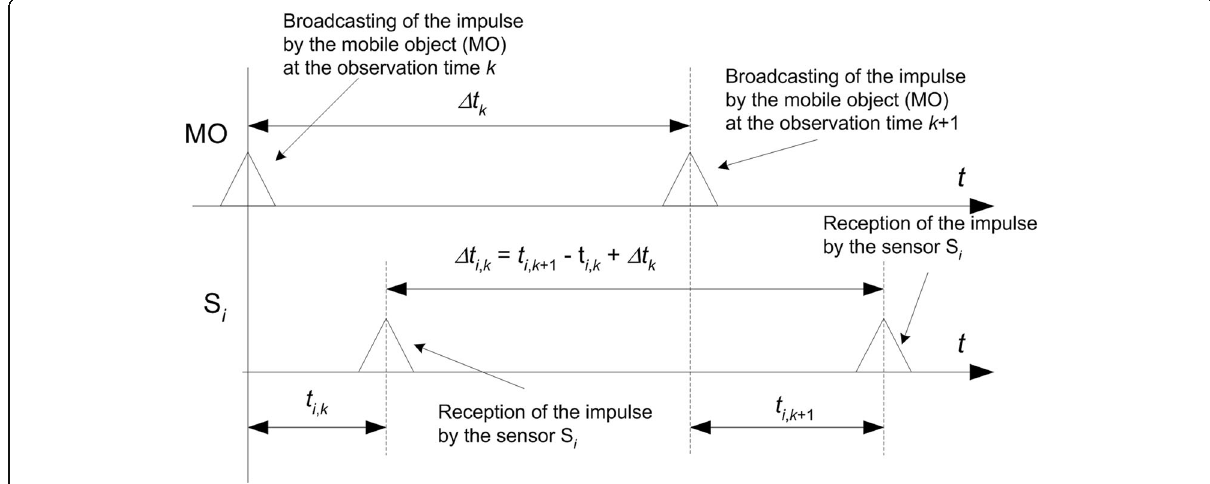
Fig. 2 Illustration of the timing of the problem under